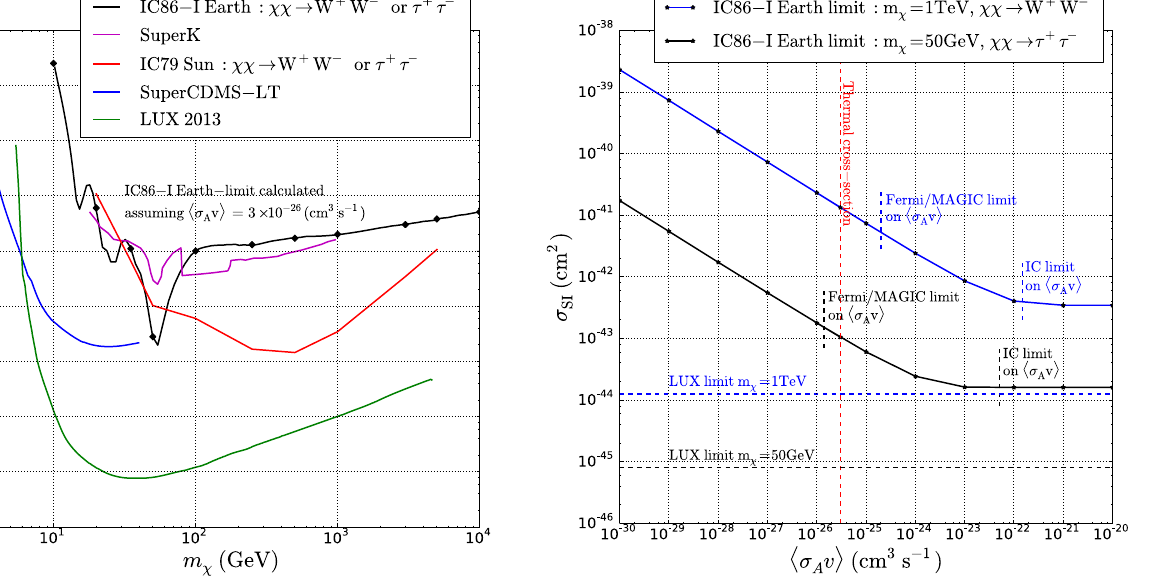
as a function X + N